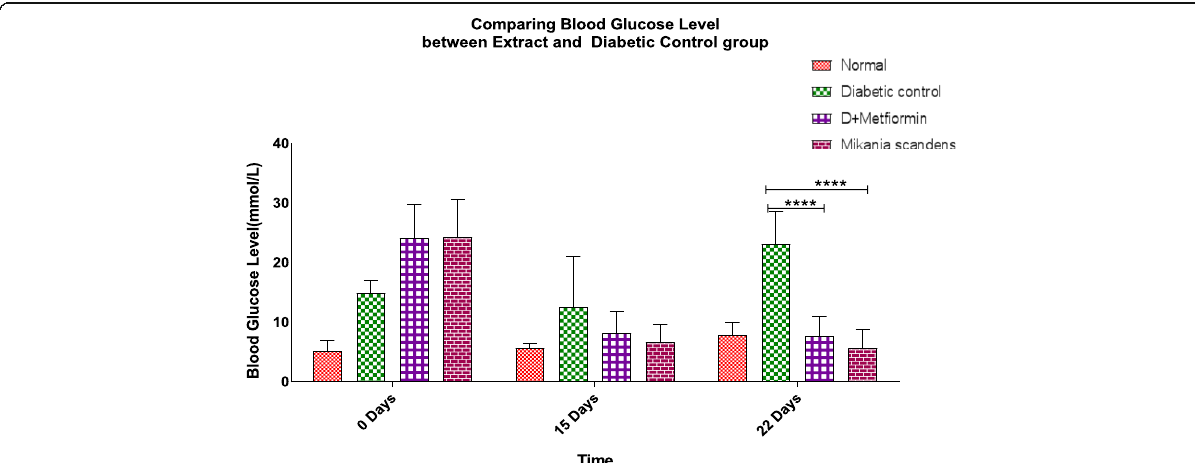
Fig. 2 Comparing blood glucose level among diabetic control, metformin HCL and Mikania scandens animal group. Significantly different ( p < 0.05) from the diabetic control. Data were analyzed by two way ANOVA followed by scheffe ’ s post-hoc test